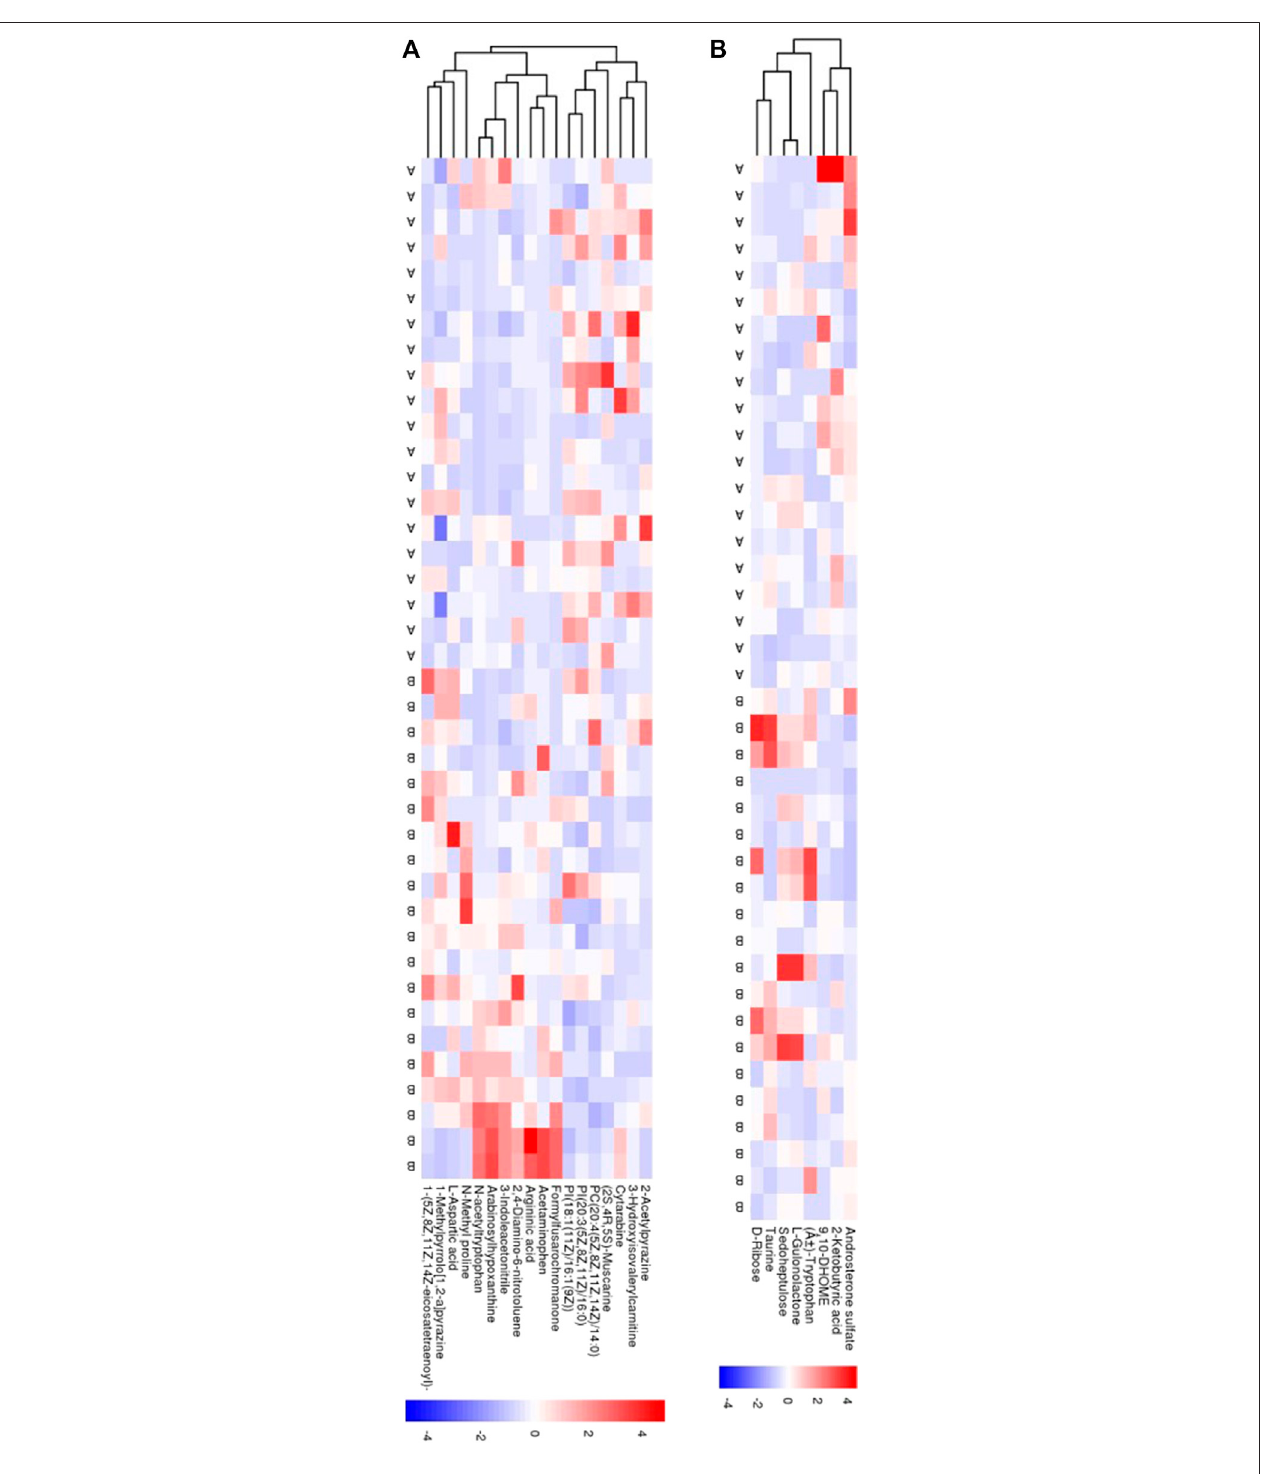
FIGURE4| Serummetabolomicanalyses. (A,B) ThePCAscoreplotandthePLS-DAscoresplotinpositiveionmodelandinnegativeionmode,respectively. (C,D) Heatmaps of 18 metabolites and 8 metabolites in positive ion model and in negative ion model, respectively. Blue circle: QC sample, green circle: nonSAE group, red circle: SAE group. A: SAE group; B: nonSAE group.